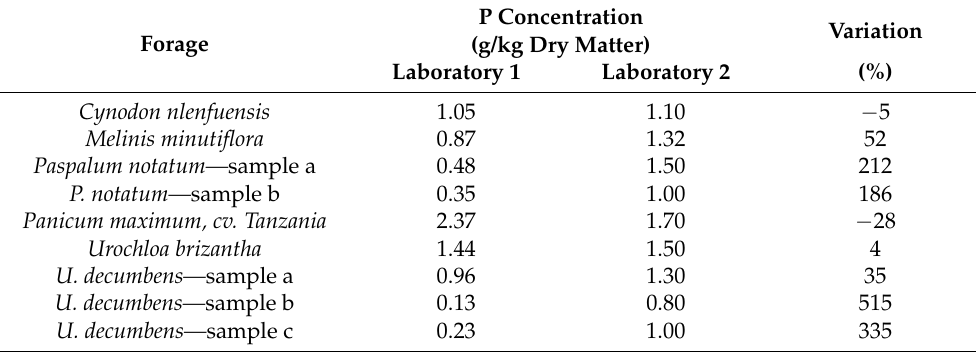
Table 2. Variation in P concentration between two laboratories. The forages were collected, dried (60 °C over 72 h), ground and then 50% was sent to each of the two laboratories 1 .